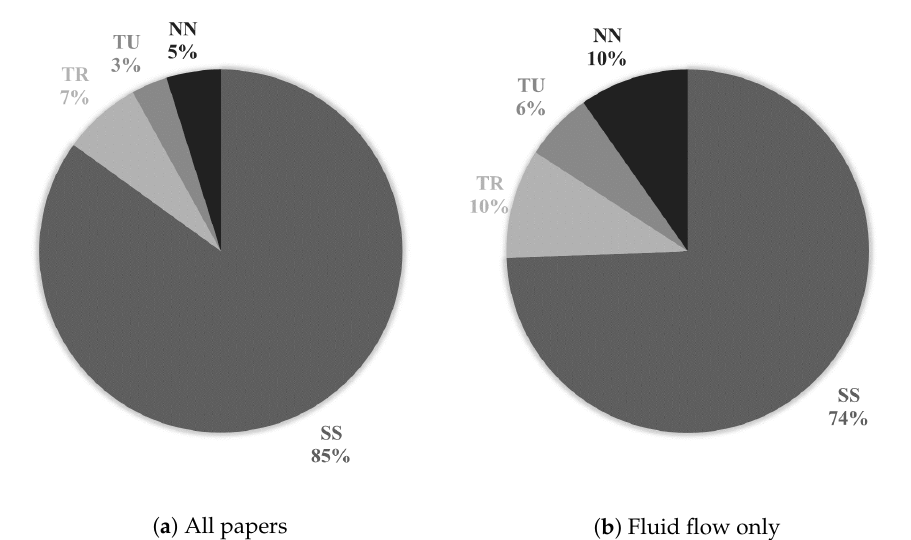
Figure 8. Distribution of papers for fluid model type: SS = steady-state laminar flow; TR = transient laminar flow; TU = turbulent flow; NN = Non-Newtonian fluid.